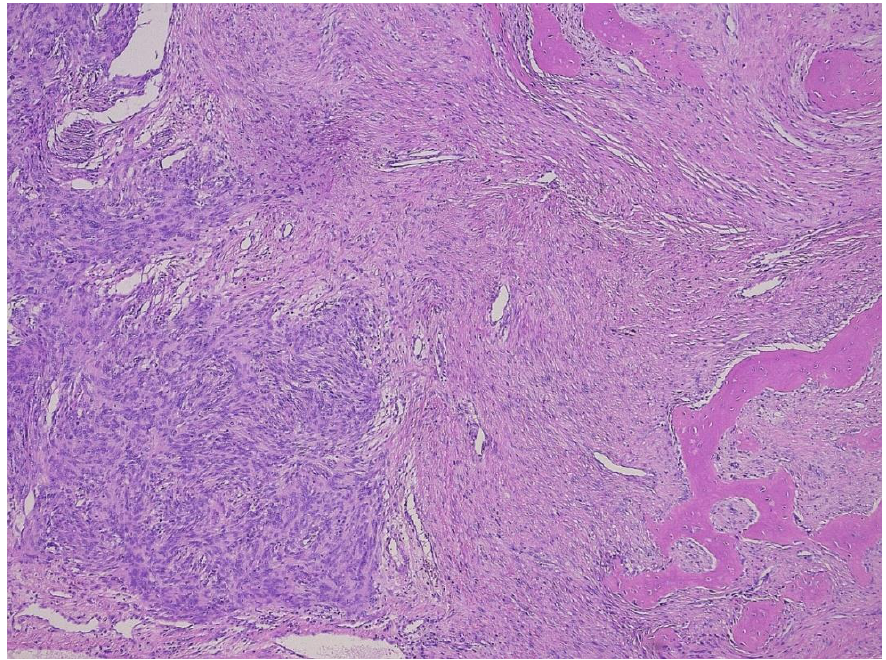
Figure 9. Meningothelial-like whorls and metaplastic bone formation in a retroperitoneal dediffer- entiated liposarcoma (H&E).